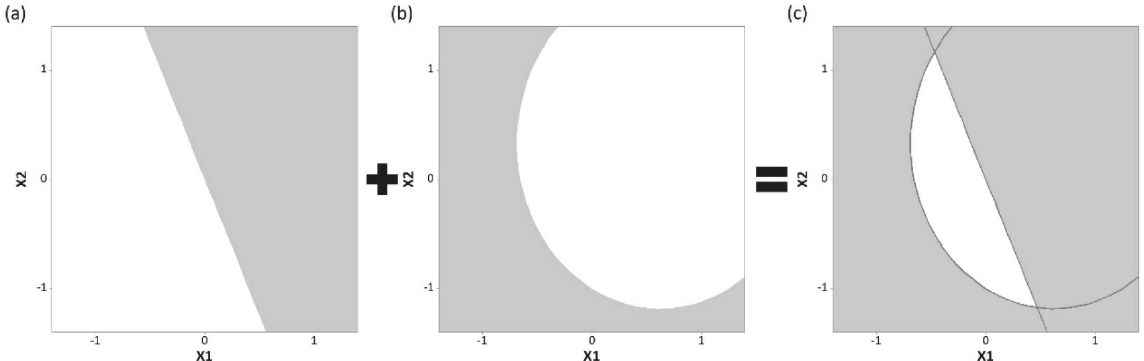
FIGURE 7 – Design space (white regions) obtained from counter plot of output response Y1 (a), from counter plot of output response Y2 (b), and from overlaid counter plot of output responses Y1 and Y2 (c) as function of input factors X1 and